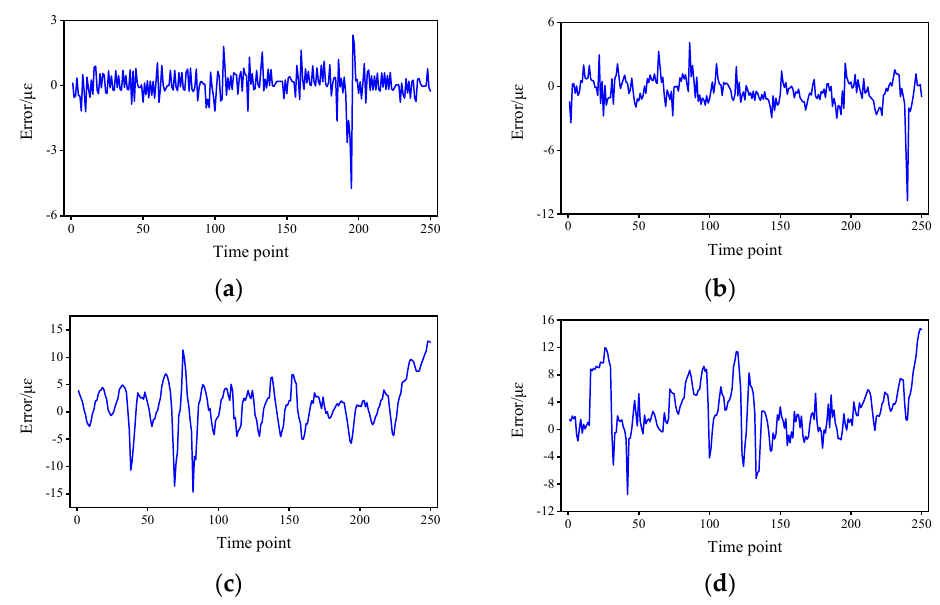
Figure 9. Prediction errors at different time intervals. ( a ) 0.5 h. ( b ) 1 h. ( c ) 1.5 h. ( d ) 2 h.